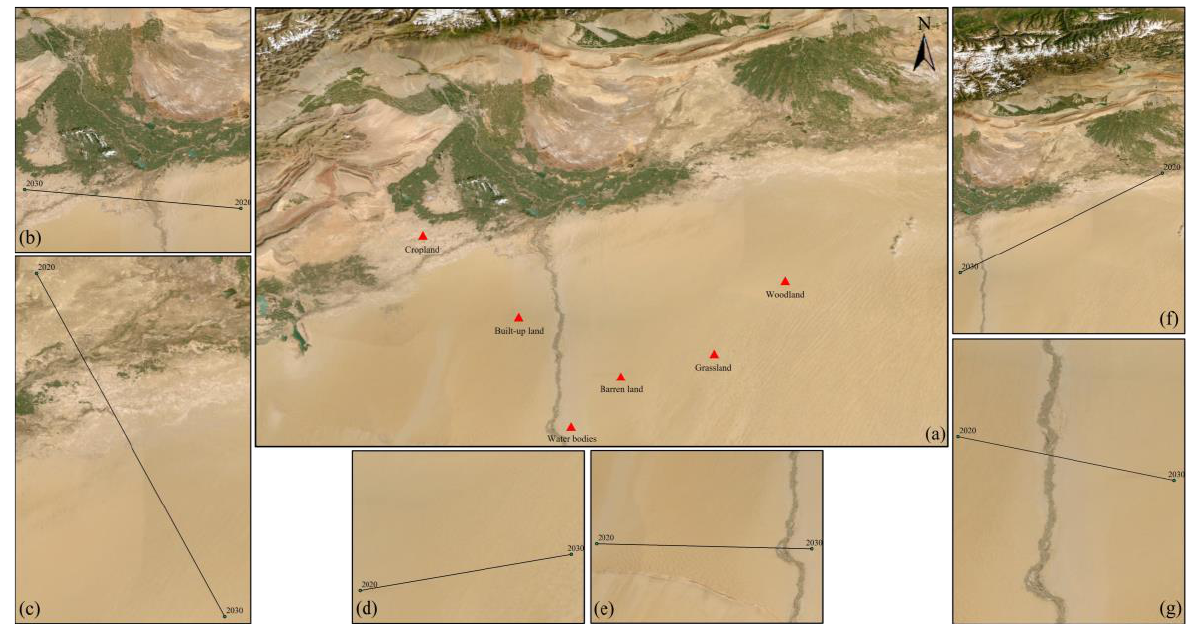
Figure 8. Migration of the center of gravity of different land types in the Tarim River Basin in the future period. (Figure ( a ) shows the center of gravity of each land type in 2030, and Figure ( b – g ) show the migration trajectories of the centers of gravity of cultivated land, forest land, grassland, water bodies, built-up land, and unused land, respectively).